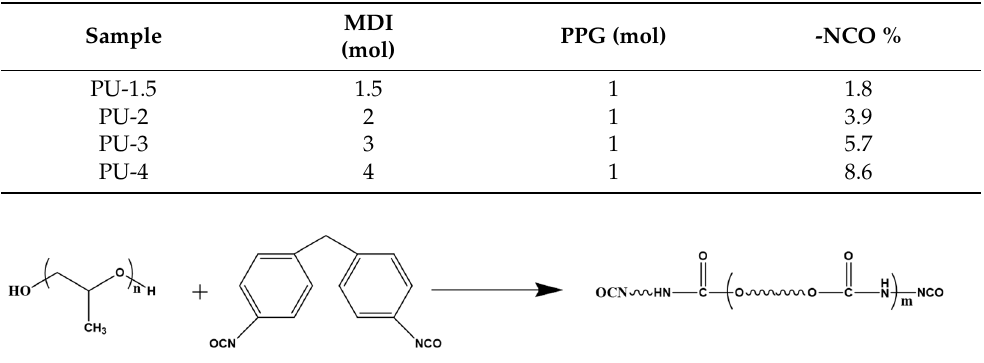
Figure 2. Preparation of PU prepolymers.